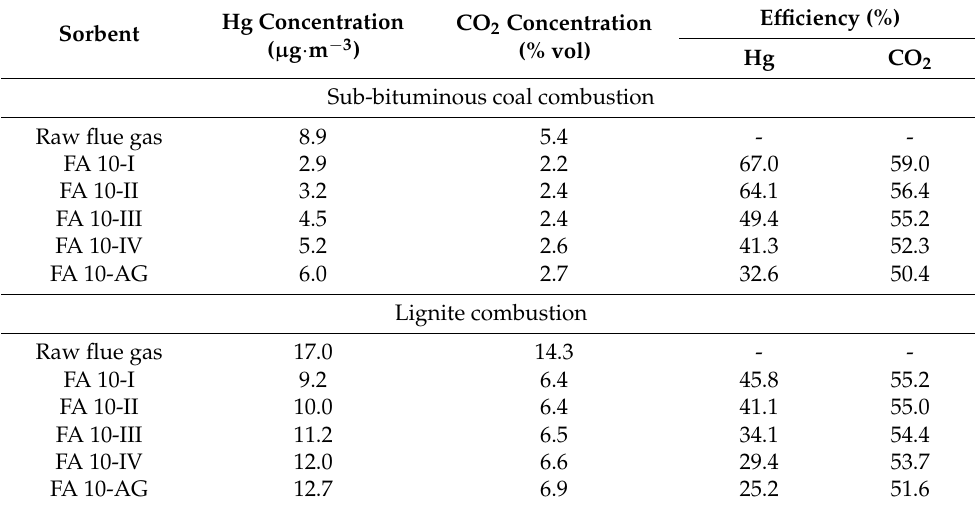
Table 7. Stream concentration-based Hg and CO 2 sorption